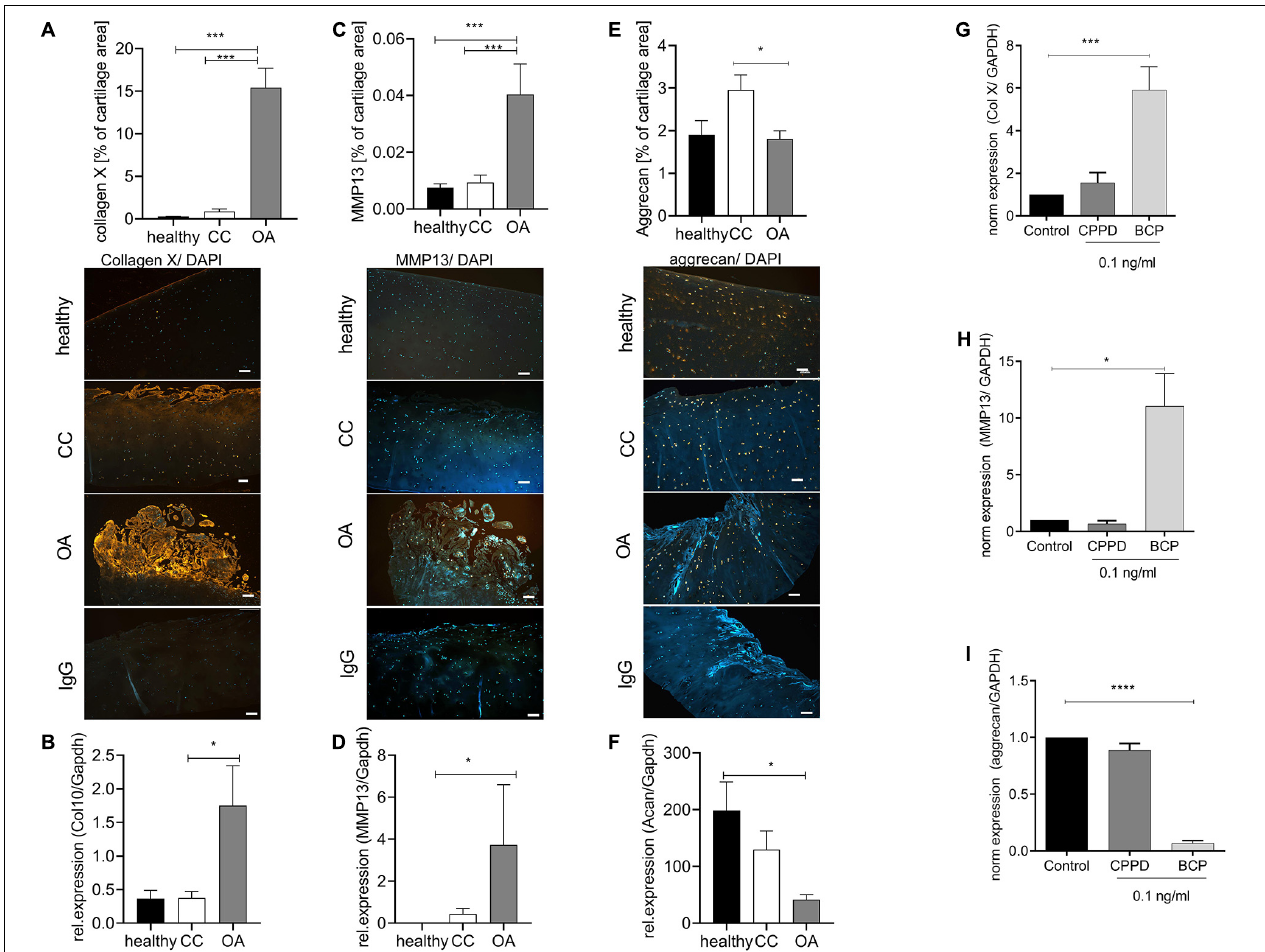
FIGURE 2 | Chondrocytes in chondrocalcinosis (CC) cartilage do not show increased markers of hypertrophic differentiation. (A) Quantification of collagen X-stained cartilage area in healthy, CC, and osteoarthritis (OA) cartilage sections [one-way ANOVA: F (2,65) = 51.06, p < 0.0001]. Representative images of collagen X staining, as well as IgG control staining, are shown (scale bar 200 µ m). (B) Quantitative RT-PCR for collagen X expression of cartilage specimens from healthy, OA, and CC cartilage [one-way ANOVA: F (2,22) = 4.12, p = 0.03]. (C) Quantification of metalloproteinase 13 (MMP13)-stained cartilage area [one-way ANOVA: F (2,62) = 12.31, p < 0.0001]. Representative images of MMP13 staining, as well as IgG control staining, are shown (scale bar 200 µ m). (D) Quantitative RT-PCR for MMP13 expression of cartilage specimens from healthy, OA, and CC cartilage [Kruskal–Wallis test: F (2,22) = 10.4, p = 0.006]. (E) Quantification of aggrecan-stained cartilage area in healthy, CC, and OA cartilage sections [one-way ANOVA: F (2,41) = 3.796, p = 0.03]. Representative images of aggrecan staining, as well as IgG control staining, are shown (scale bar 200 µ m). (F) Quantitative RT-PCR for aggrecan expression of cartilage specimens from healthy, OA, and CC cartilage [one-way ANOVA: F (2,12) = 5.043, p = 0.025]. (G) Quantitative RT-PCR for collagen X expression of C28 chondrocytes stimulated with 0.1 ng/ml of either calcium pyrophosphate dihydrate (CPPD) or basic calcium phosphate (BCP) crystals [one-way ANOVA: F (3,10) = 9.86, N = 3–5, p = 0.0025].